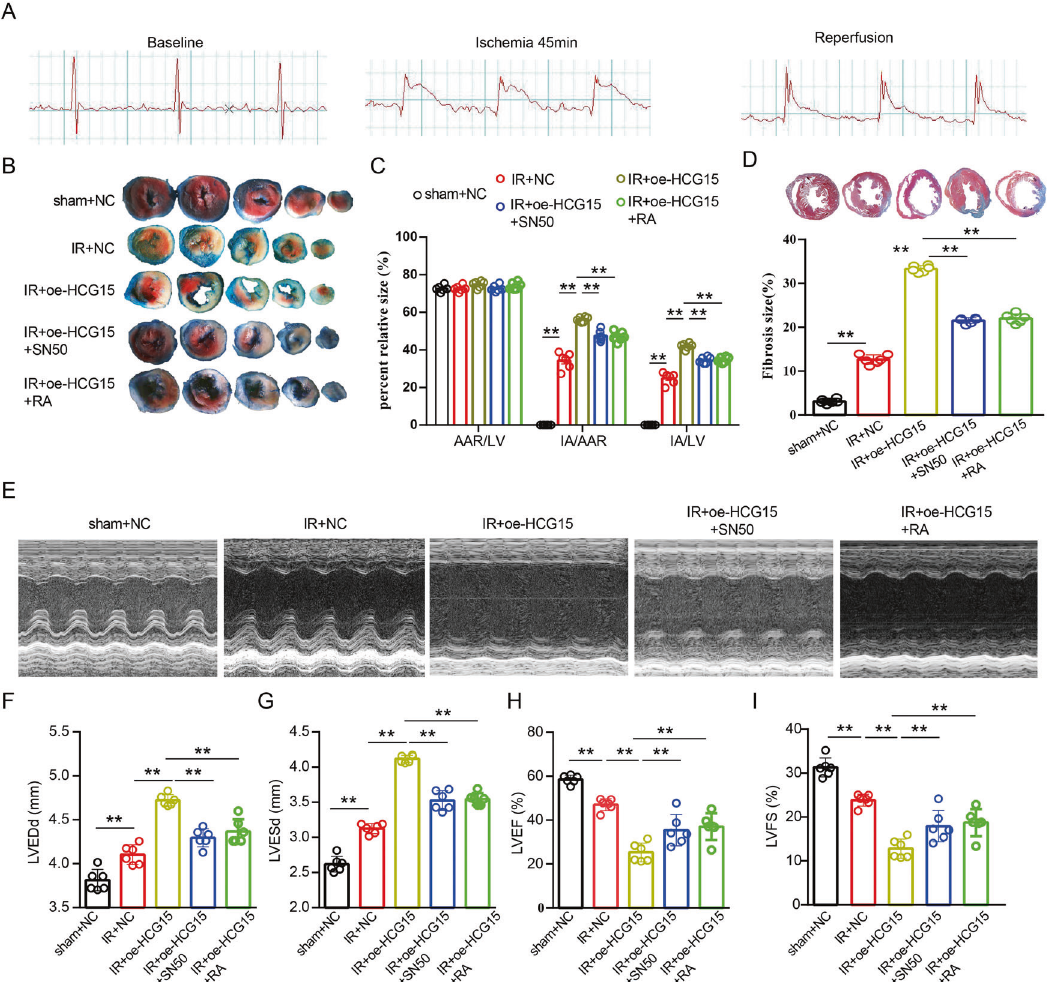
Myocardial IS in the indicated groups at 4 weeks after surgery; n = 5 per group, ** p < 0.05. D Representative images of Masson staining of ventricular sections from mice at 4 weeks after cardiac IR and quantitative analyses of infarct size; scale bar = 1 mm; n = 5 per group, ** p < 0.05. E – I Representative images of M-mode echocardiography ( E ) and relative indices of LVEDD ( F ), LVESD ( G ), LVEF ( H ), and LVFS ( I ) in mice at 4 weeks after cardiac IR, n = 5 per group, ** p < 0.05. NF- κ B antagonist (SN50); p38 MAPK antagonist (ralimetinib (LY2228820) dimesylate);